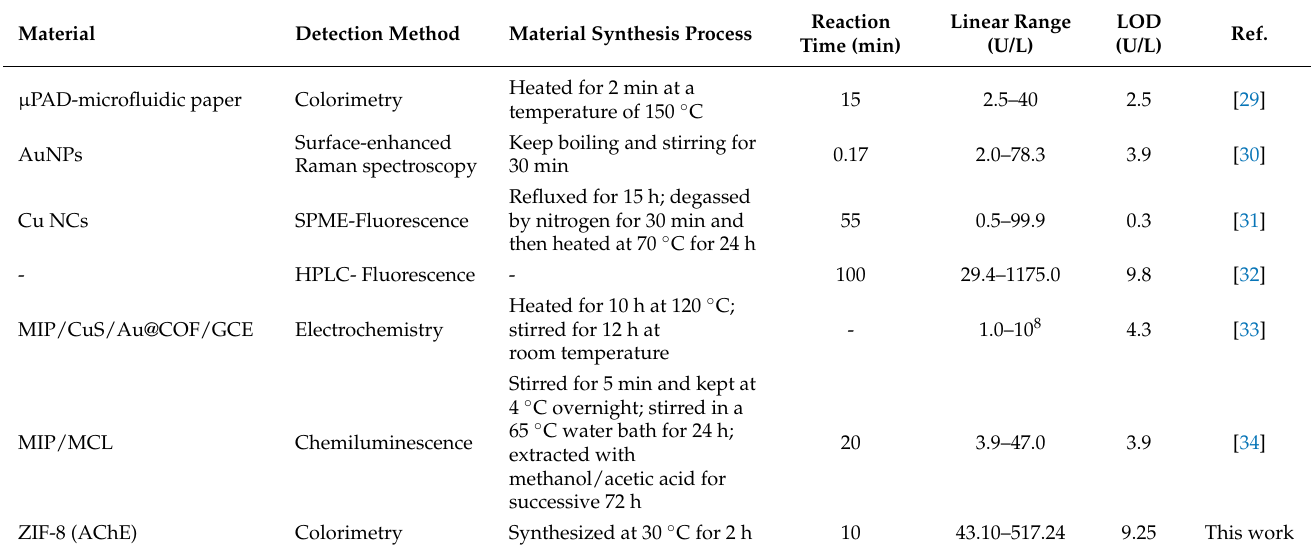
Table 2. Comparison of the previously reported methods and present work for the detection of